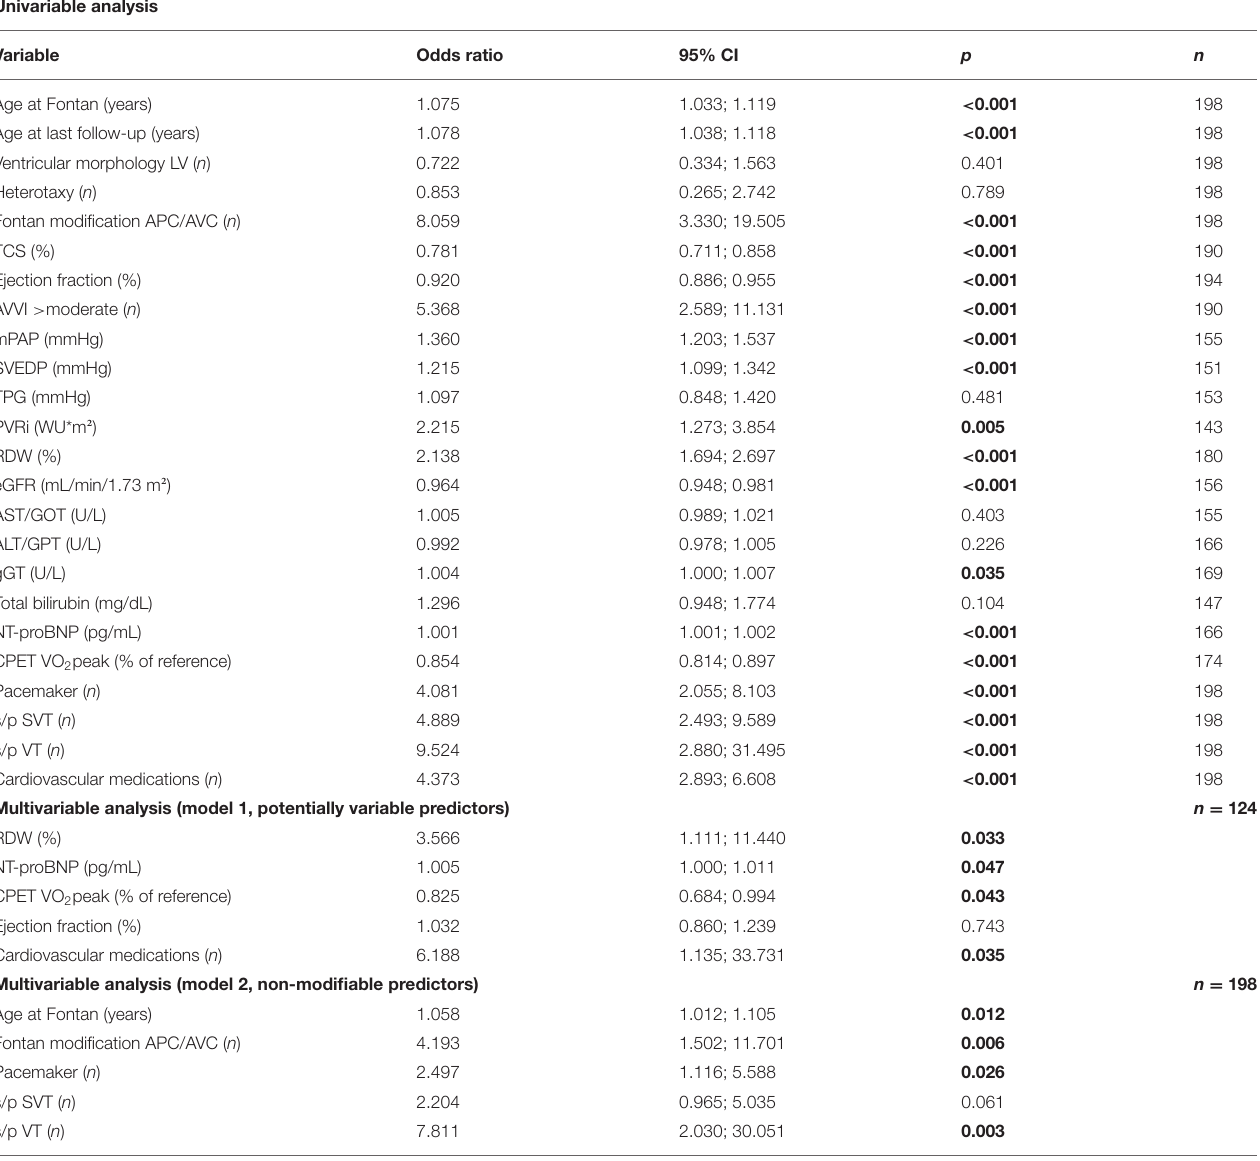
TABLE 2 | Univariable and multivariable analysis for Fontan failure. Univariable